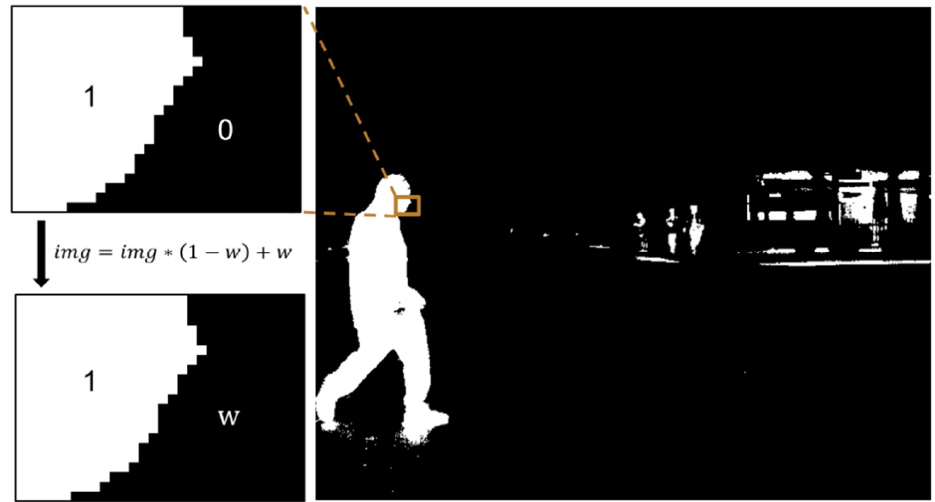
Figure 7. An example of converting the temperature mask map to a weighted